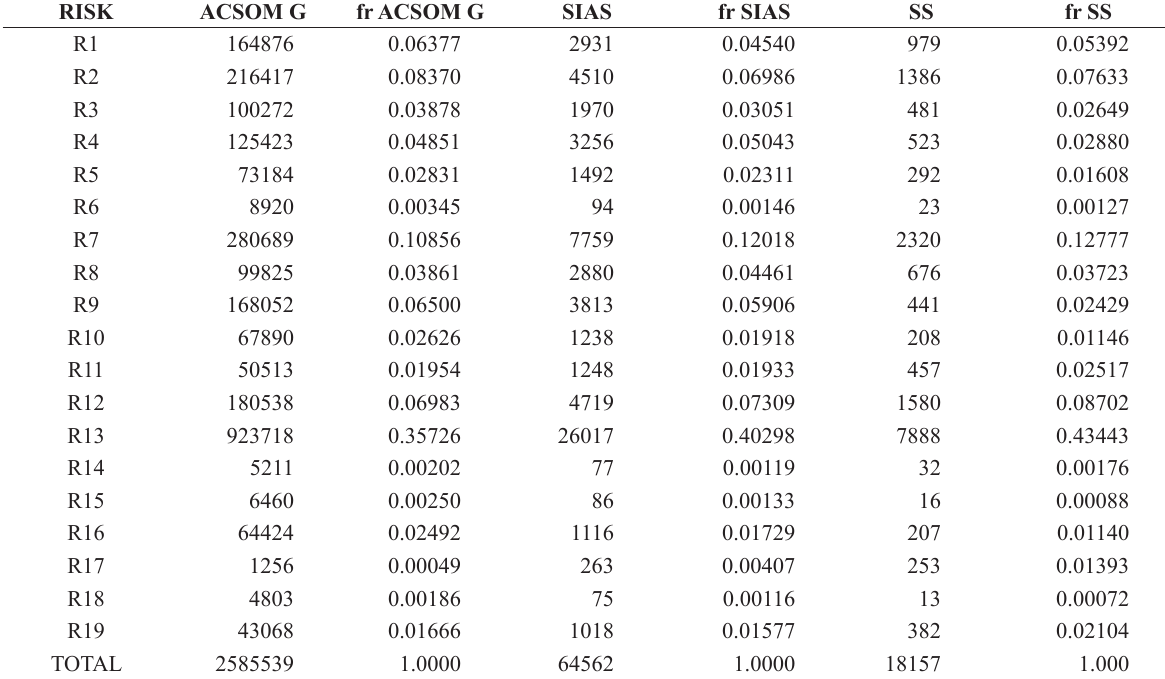
Absolute and relative values of risks in ACSOM-G, SIAS and